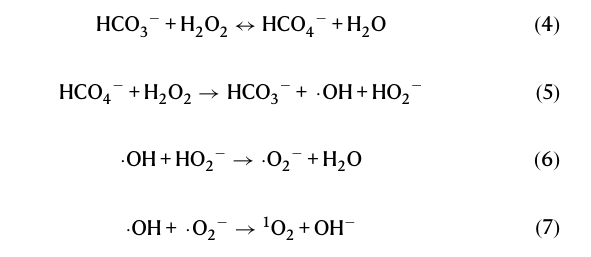
(7cm 2 ). c Photocurrent – time pro fi les of SnO 2-x /BiVO 4 /WO 3 ||PTFE@Mo-SACs/mrG- GDE under bias-free conditions. d Degradation of 15 ppm NP with consumption of only oxygen and sunlight. Reaction electrolyte: 15mL of 0.4M NaHCO 3